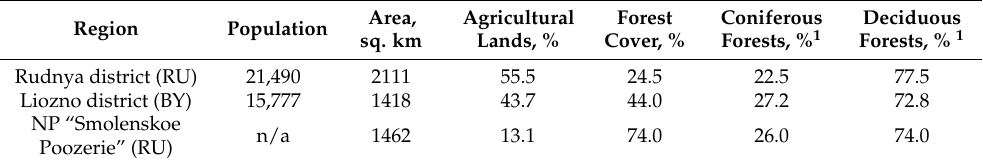
Table 1. Main up-to-date characteristics of regions within the extended study area. Region Population